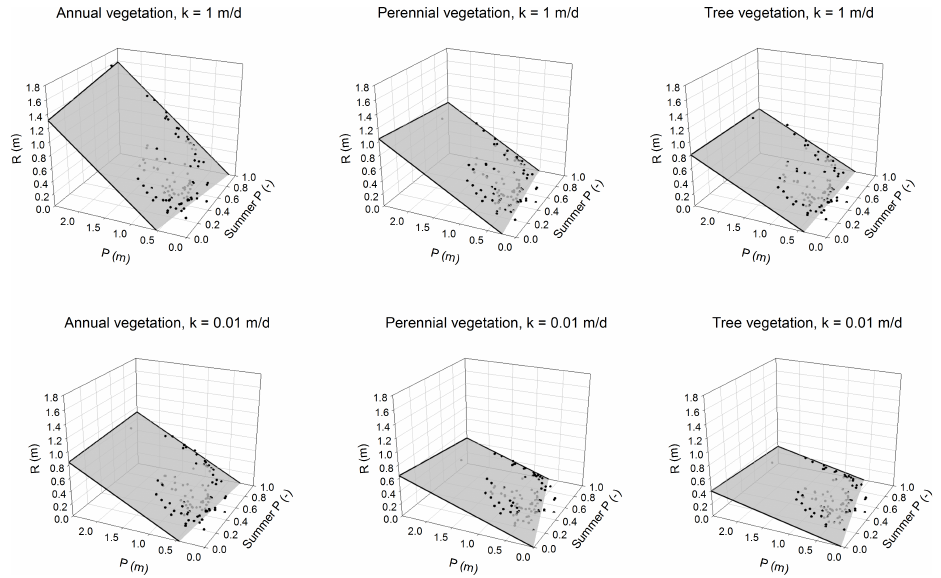
Fig. 10. Relationship between mean annual recharge ( R ), mean annual rainfall ( P ) and proportion of annual precipitation which falls during summer (Summer P